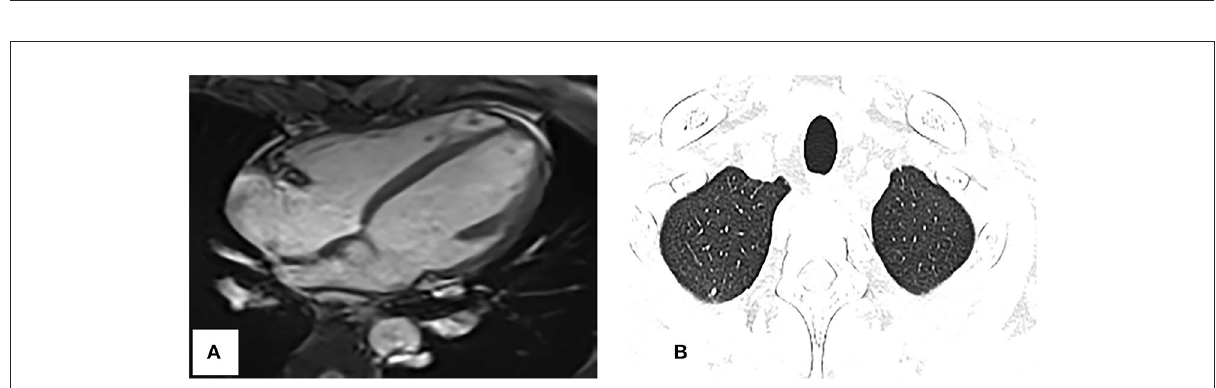
FIGURE5 Repeat cardiac magnetic resonance imaging and thoracic CT. (A) SSFP cine imaging planned in the four chambers shows the tumor markedly reduced. (B) Thoracic CT shows the pulmonary nodules obviously decreased too, compared with Figure